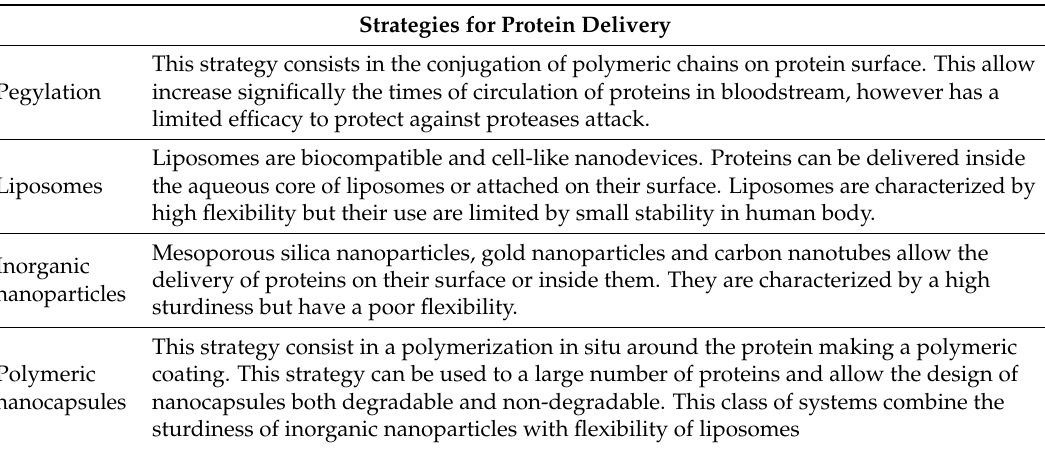
Table 1. Summary of Protein Delivery